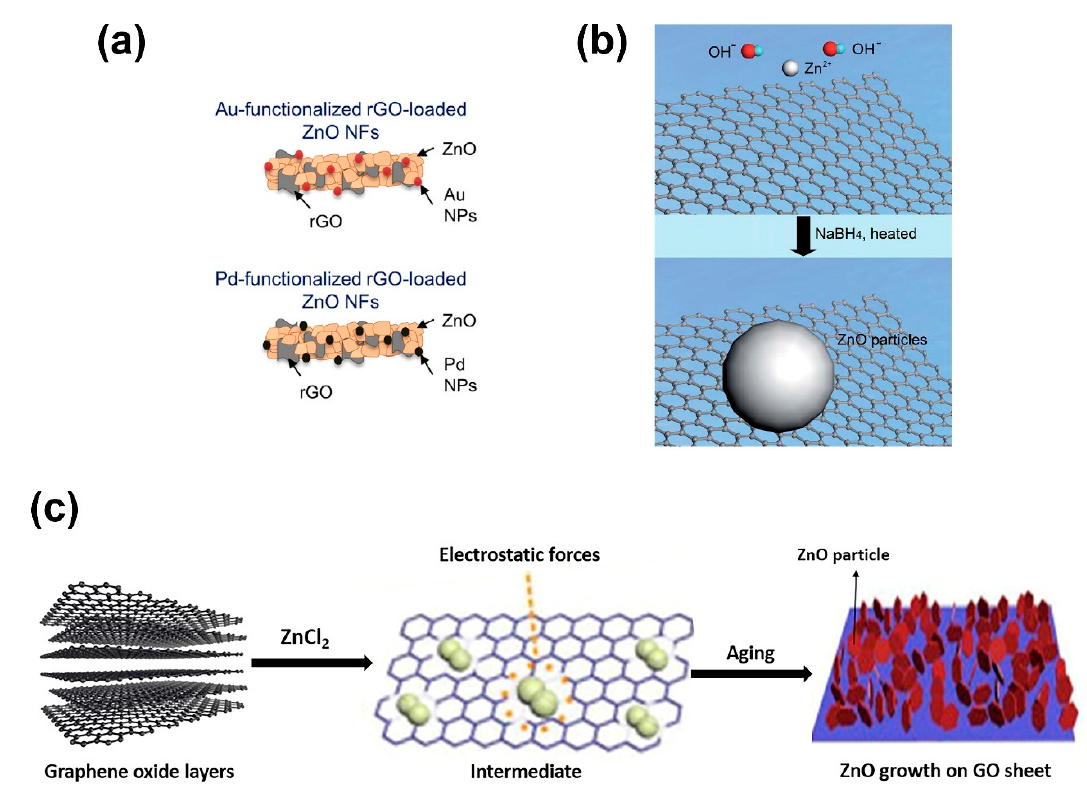
Figure 5. ( a ) Synthesis based on electrospinning for Au- or Pd-functionalized rGO-loaded ZnO nanofibers (reproduced with permission from ref. [66], with permission from Elsevier, 2018), ( b ) illustration of the chemical deposition of ZnO on rGO (reproduced with permission from ref. [62], with permission from RSC Publishing, 2016), and ( c ) illustration of the in situ growth of ZnO on the surface of GO.